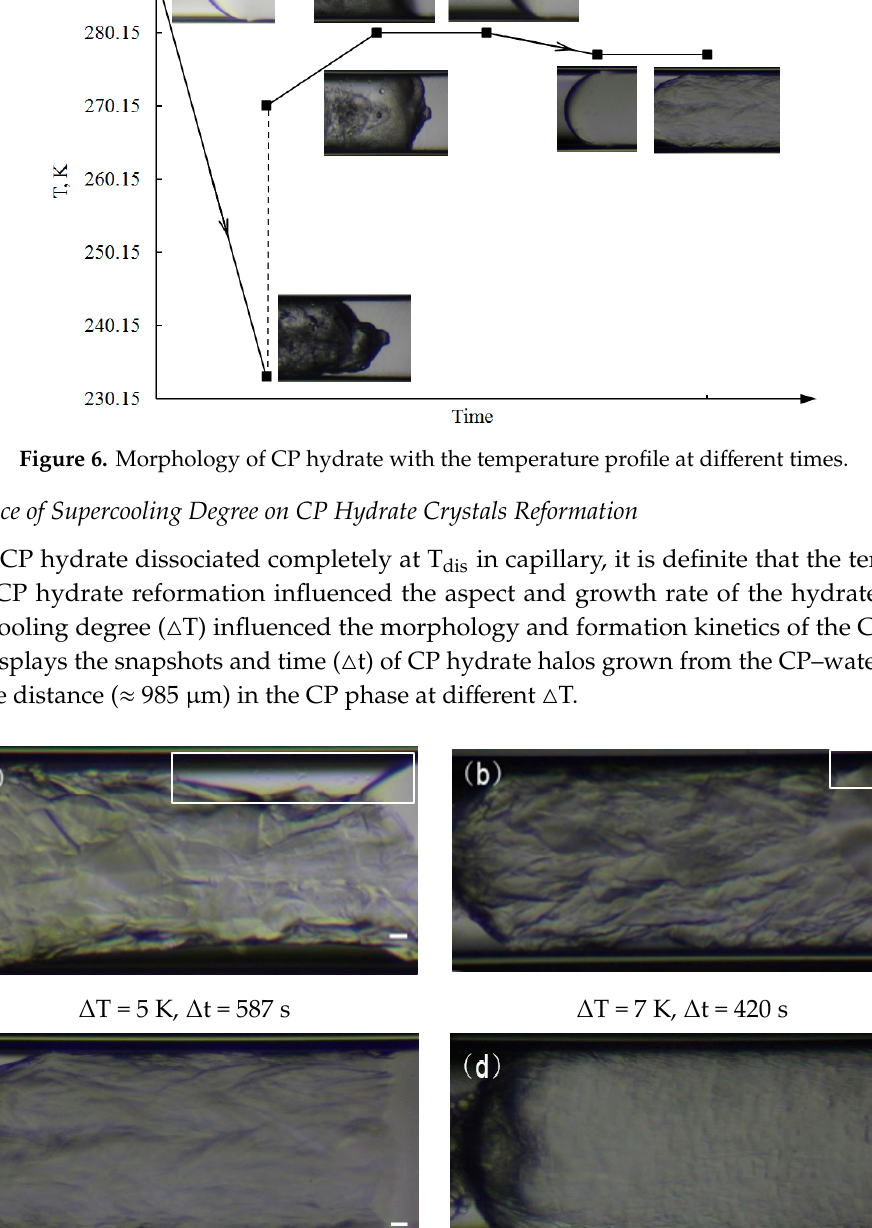
Figure 6. Morphology of CP hydrate with the temperature profile at different times.